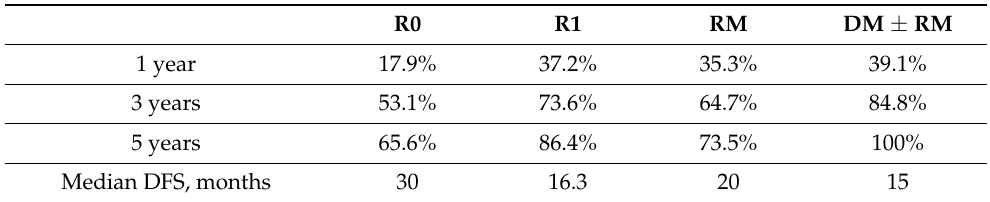
Table 6. Kaplan-Meier recurrence analysis.